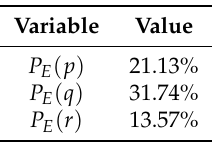
Table 14. Percentage error in